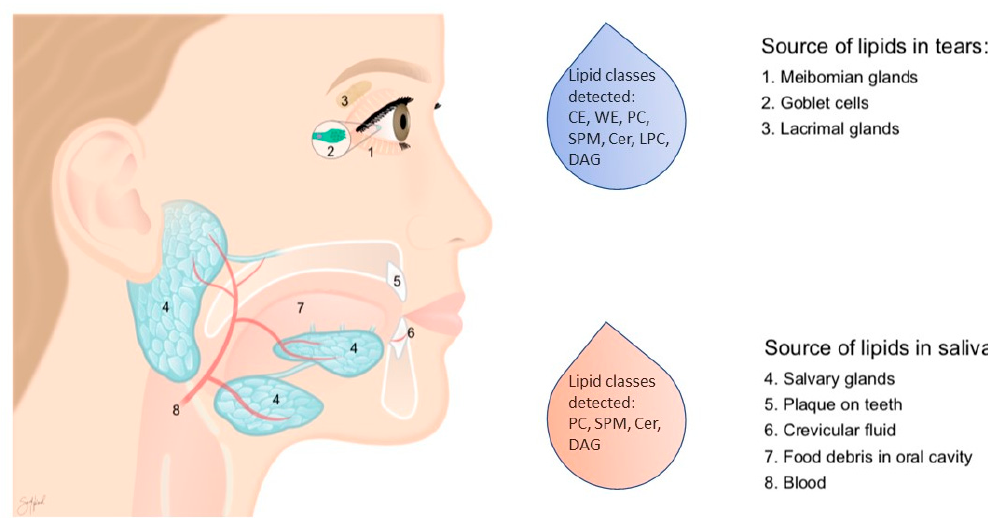
Figure 8. An overview of identified lipids and their origin. CE: cholesterol ester; WE: wax ester; SPM: sphingomyelin; Cer: ceramide; LPC: lysophosphatidylcholine; DAG: diacylglycerol; PC: diacylglycerophosphocholines. (Figure produced by Sara Nøland).